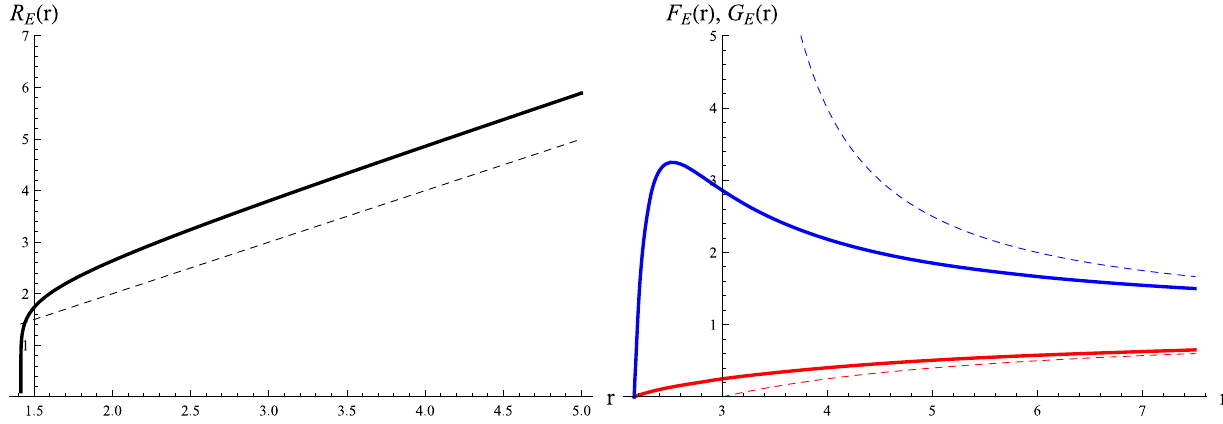
solution approaches the Schwarzschild solution. On the other hand, as r goes to zero, R E rapidly drops to zero and both of F E and G E become zero. Therefore, R E = 0 is a null surface as long as a , b > 0